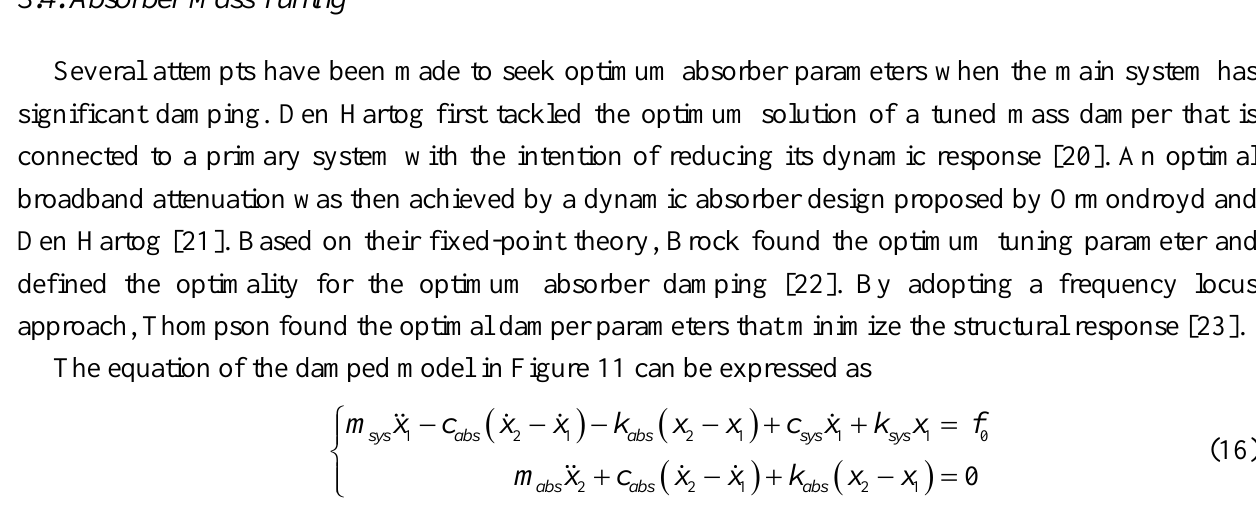
. The absorber mass m 0 1